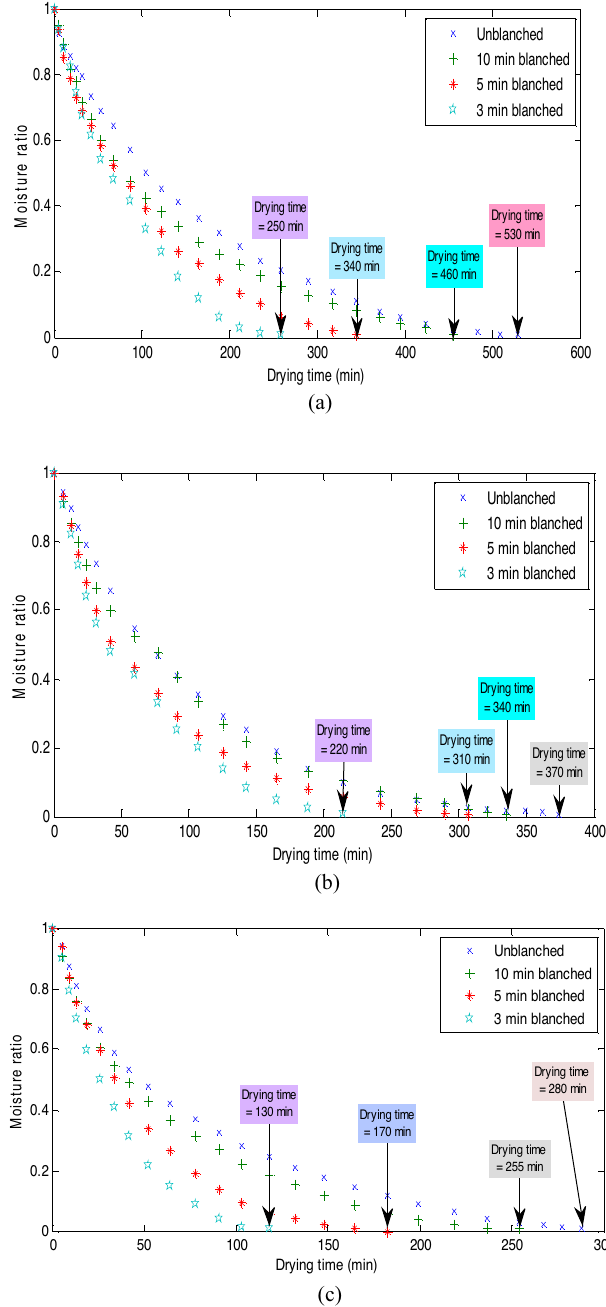
Figure 2. Effect of pretreatment and drying temperature on moisture ratio kinetics at ( a ) 50 °C, ( b ) 60 °C and ( c ) 70